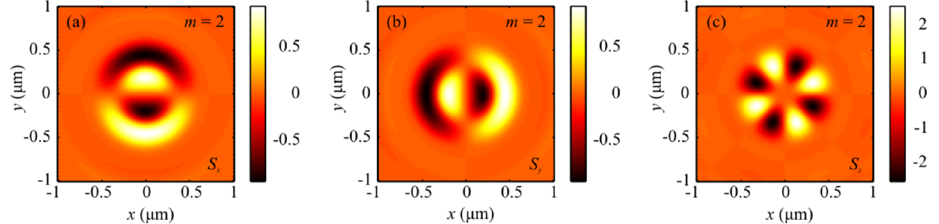
Figure 6. Distribution of the SAM components ( a – c ) S x , S y , and S z when focusing a plane wave with the hybrid polarization in Equation (1) at m = 2.